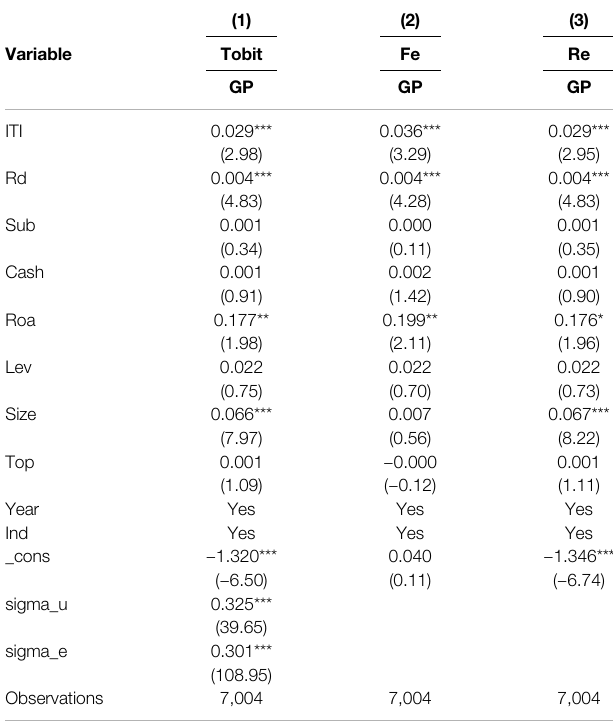
TABLE 4 | Regression results of baseline model and robustness test: alternative estimation